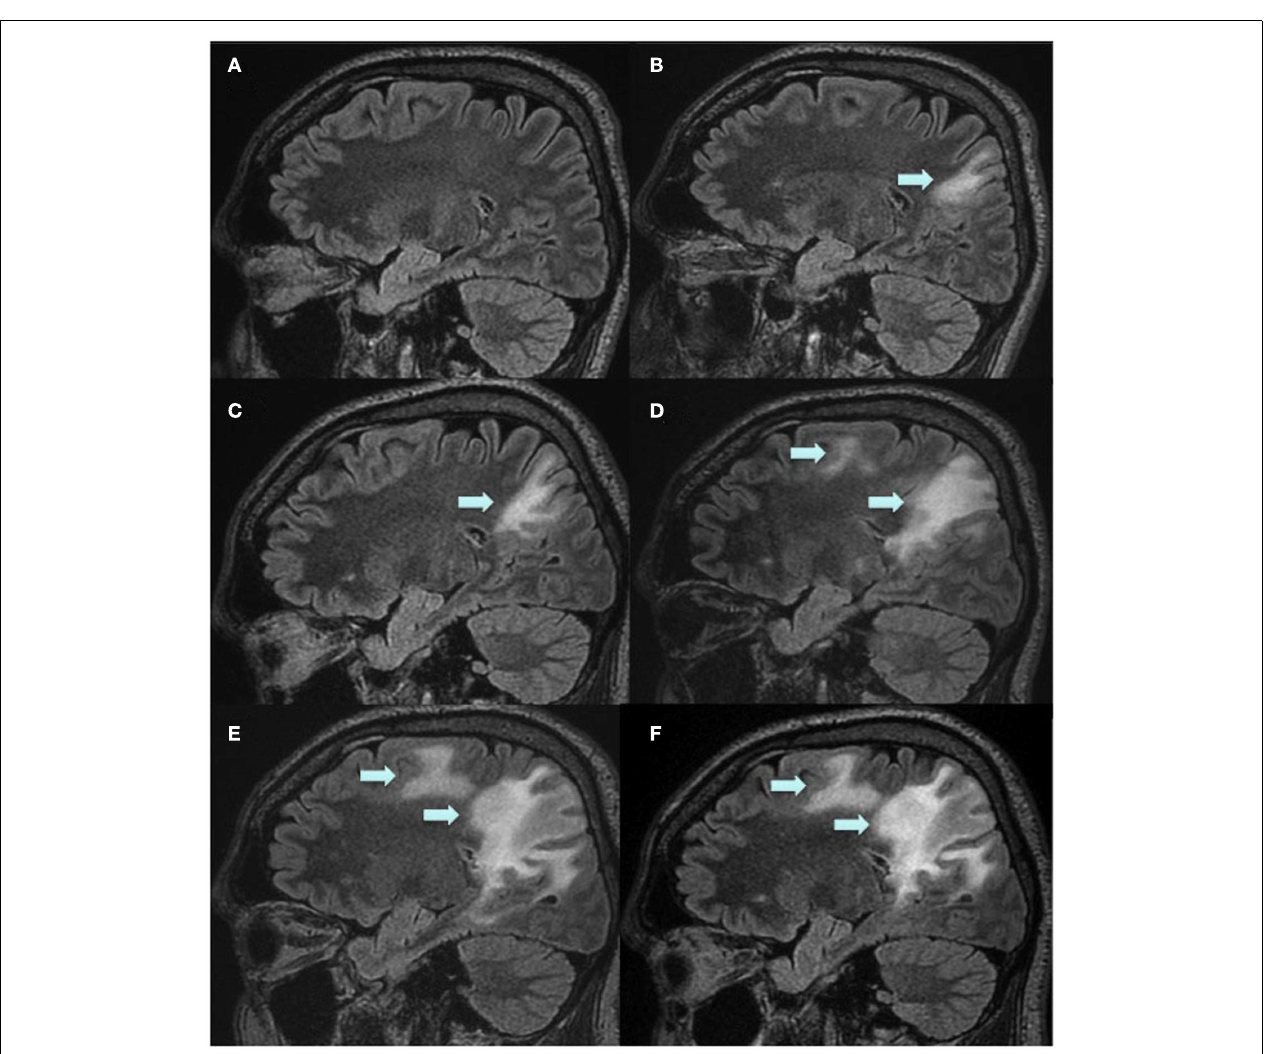
was diagnosed (B) and subsequent scans 2weeks (C) , 1.5months (D) , 2.5months (E) , and 3.5months (F) after plasma exchange. Arrows indicate the PML